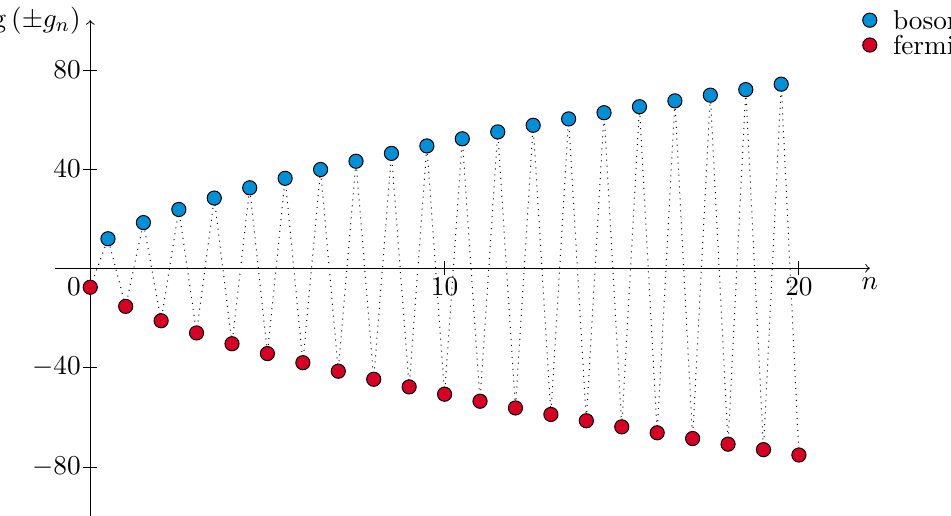
Figure 1 . The net number of physical degrees of freedom for the lightest energy levels of the heterotic SO(16) × SO(16) -theory, defined as ( − 1) F n g = N ( n ) − N ( n ) . Each point corresponds to n b f string states with mass M 2 = 4 n/α 0 , for n = 0 , 1 / 2 , 1 , . . . , 20 . A positive value indicates a surplus n of bosonic states compared to the fermionic ones, and vice versa for negative values. The presence of two misaligned sectors is clearly visible. In particular, red dots are associated to integers values of n , while blue dots to half-integers values. As predicted by misaligned supersymmetry, we observe an exponentially growing oscillation between the net number of bosons and